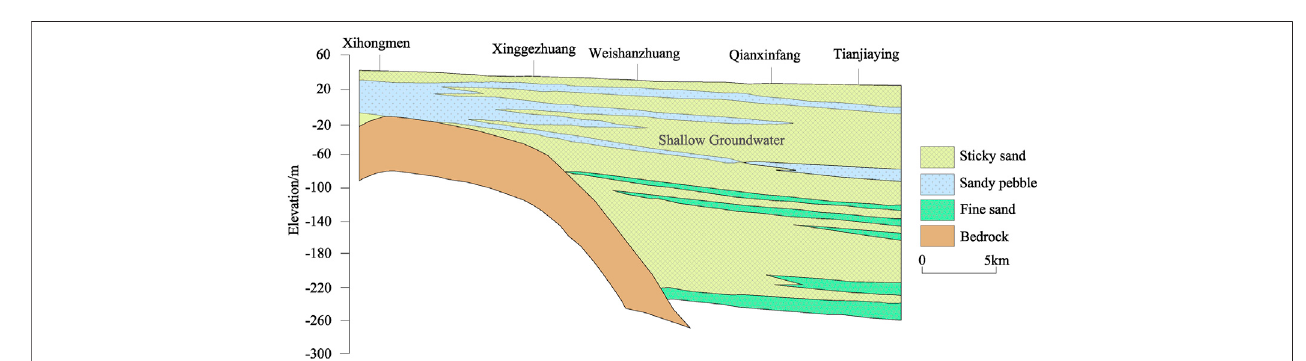
FIGURE 2 | Section A – A ′ of the study